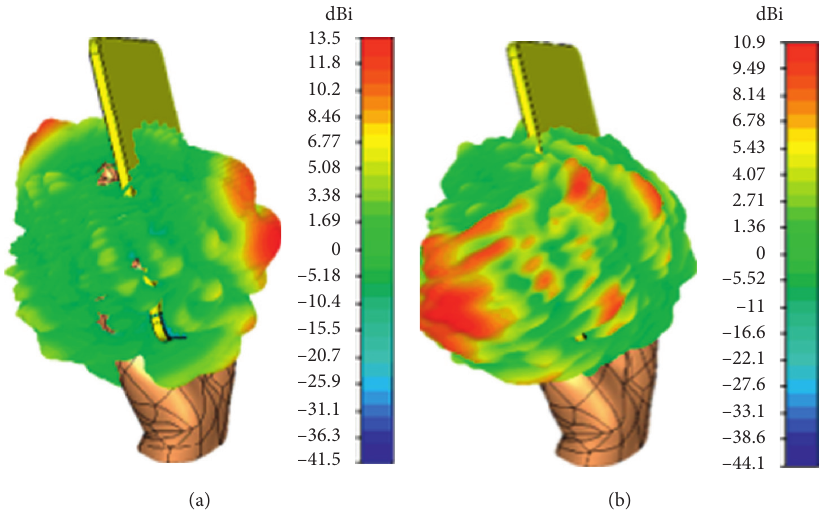
Figure 8: Antenna array radiation patterns for PBS integrated into the form factor with the hand grip. Each plot’s colorbar refers to its maximum value with a common dynamic range of 40dB: (a) ψ � 90 ° ; (b) ψ � 70 ° .